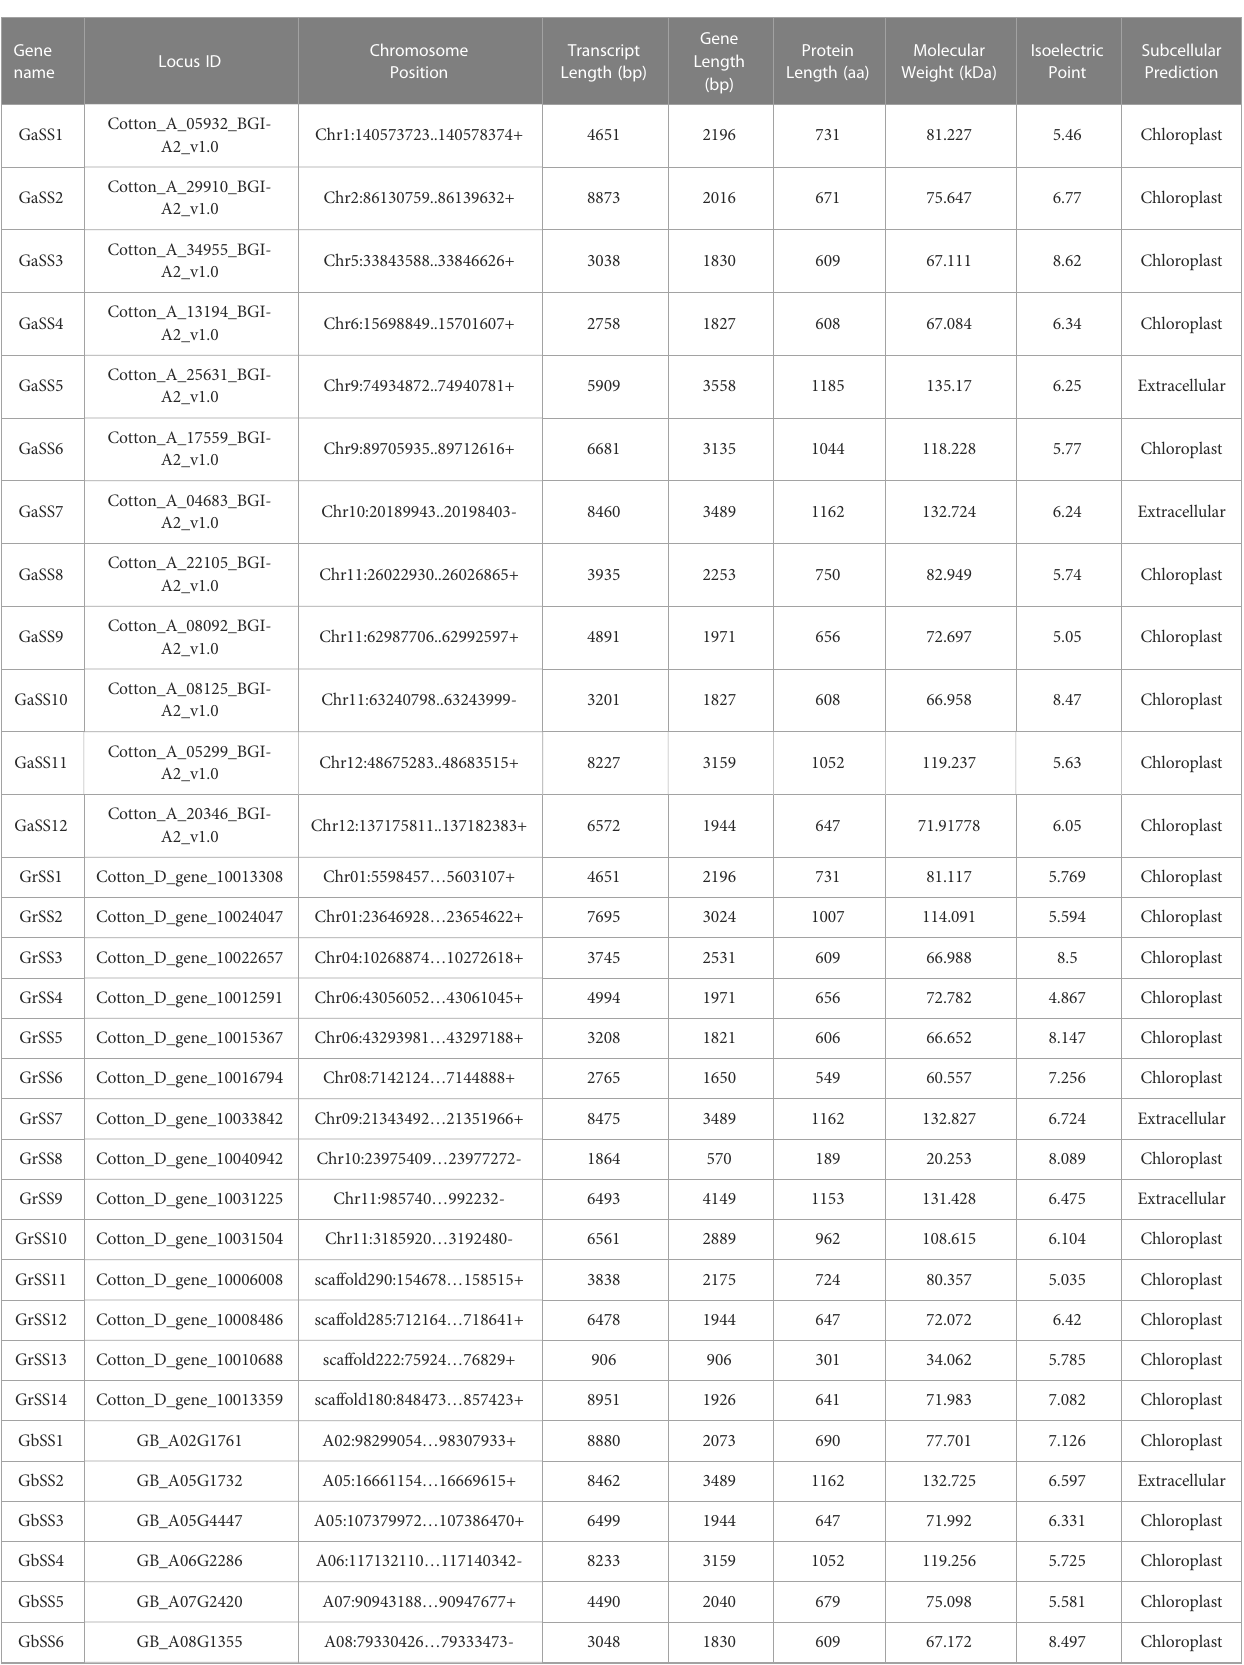
TABLE 1 Information of the SS genes in